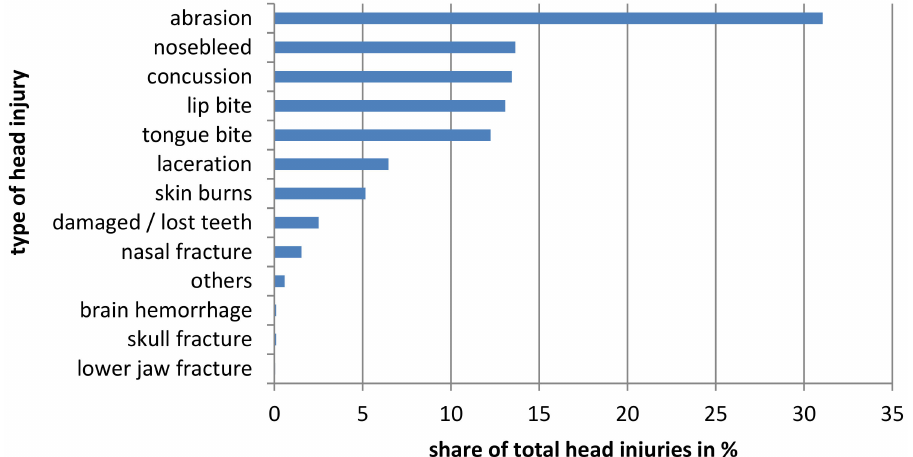
Figure 1. All recorded head injuries are shown.